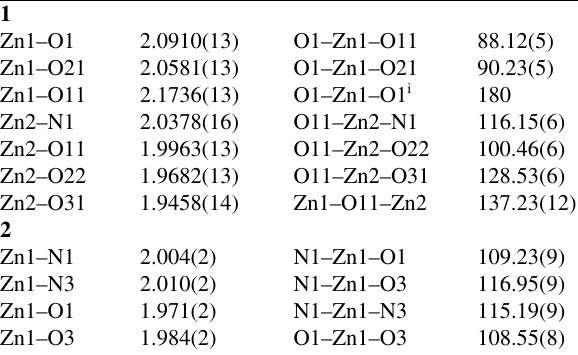
Table 1. Selected bond lengths (Å) and angles (°) for 1 and 2 .